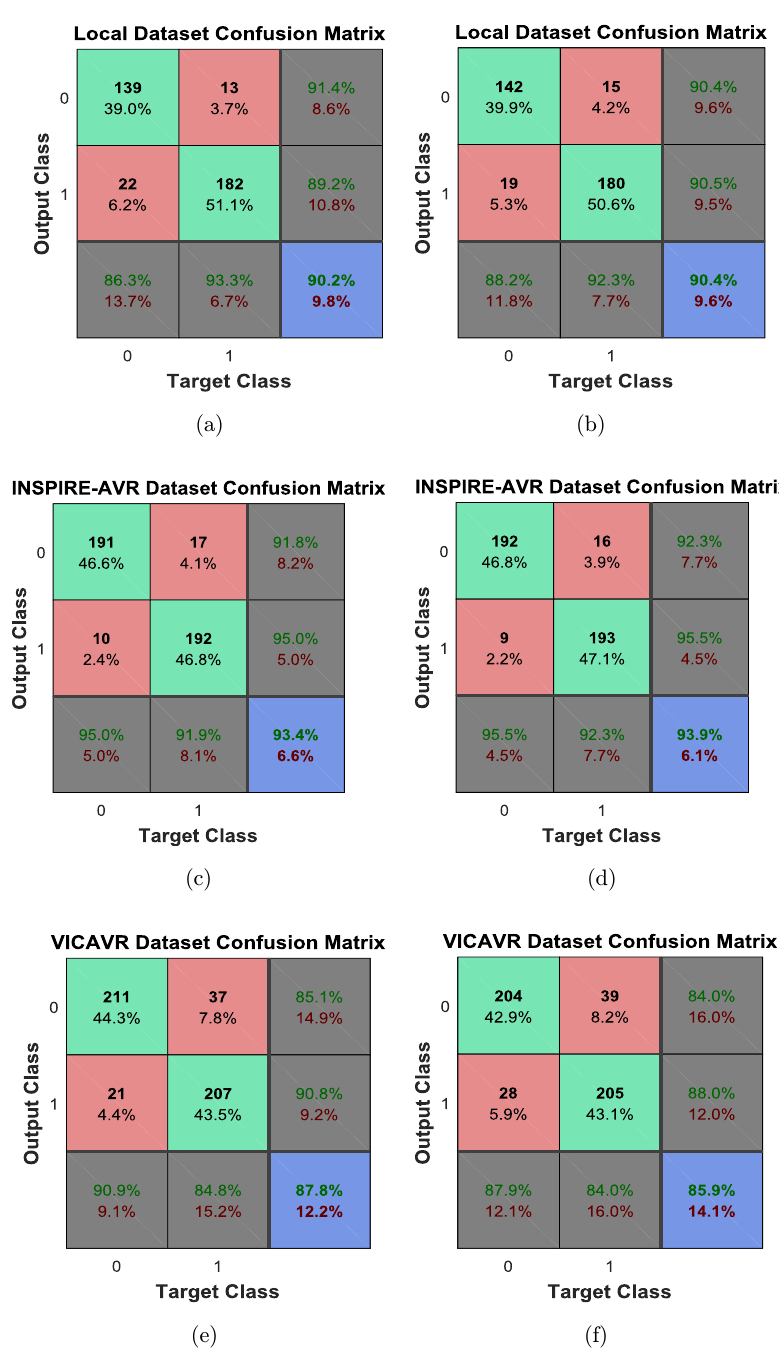
Fig. 21. Confusion matrices obtained for hybrid classi¯cation using features selected via PCC and Relief-F method. Left side: (a), (c) and (e) Vessel labeling performance with optimal feature subsets using PCC method. Right side: (b), (d) and (f) Vessel labeling performance with optimal feature subsets using PCC